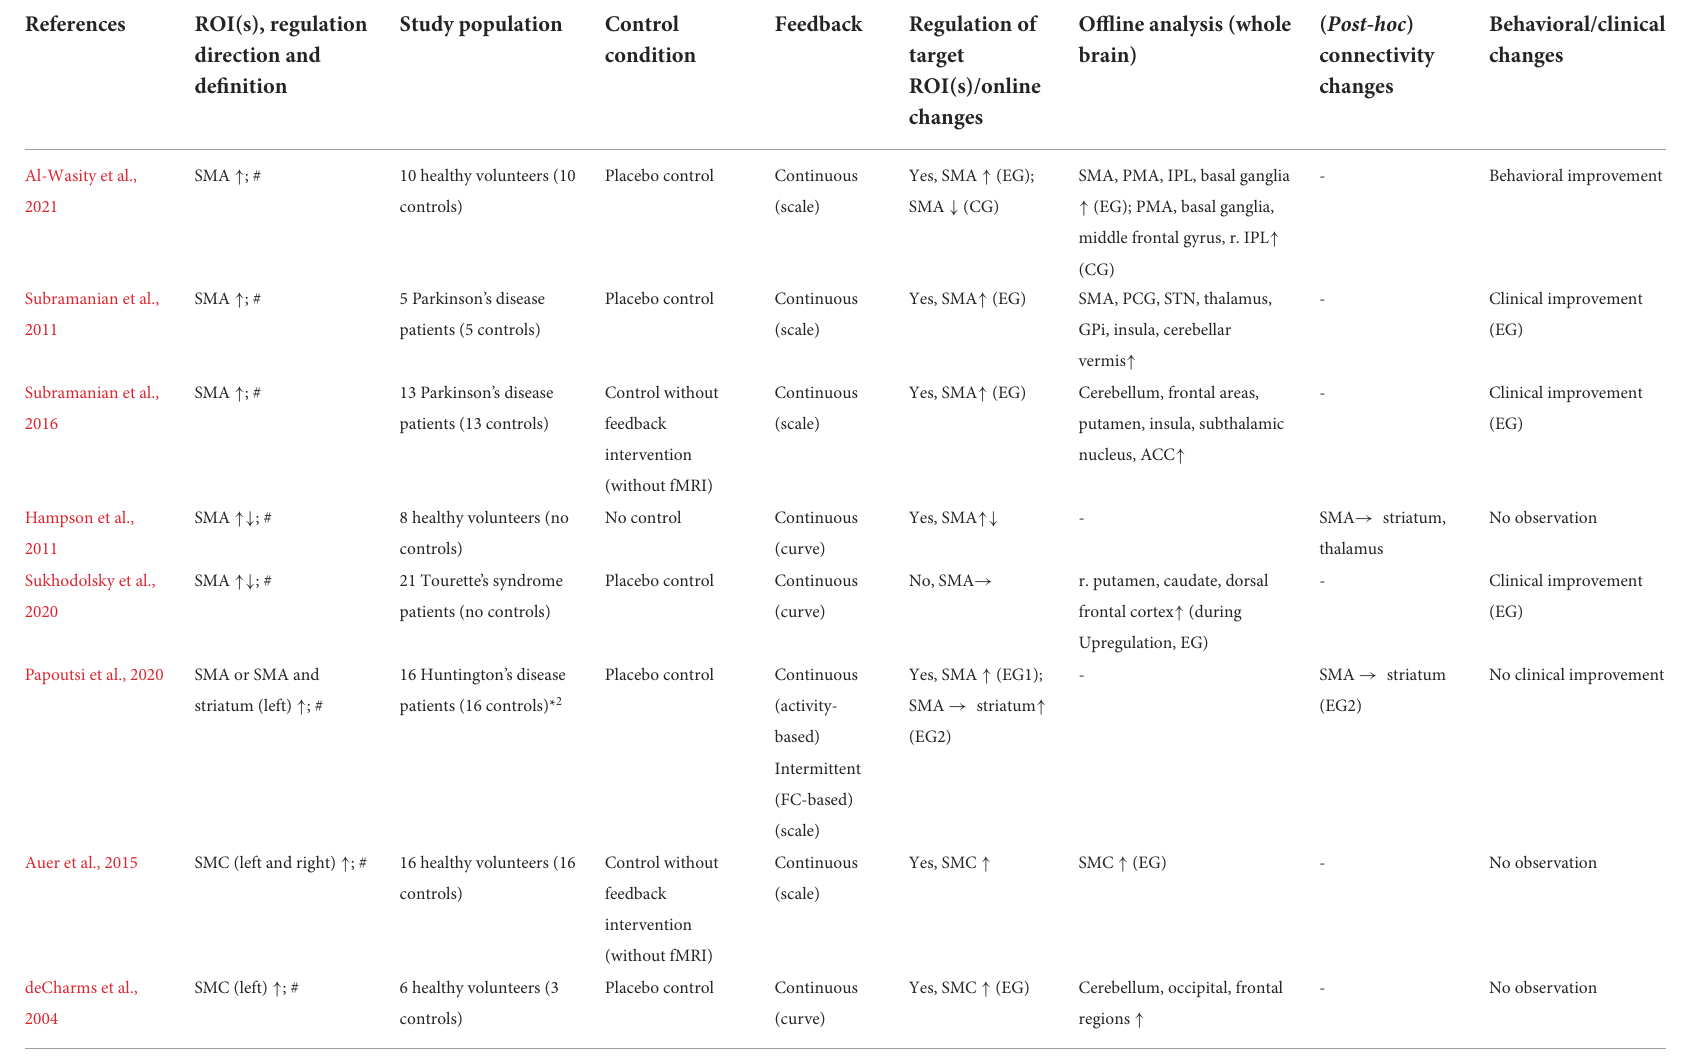
Thepublicationsaresortedbasedontheregion(s)ofinterest. CG, control group; EG, experimental group; fMRI, functional magnetic resonance imaging; HV, healthy volunteers; MCA, middle cerebral artery; NF, neurofeedback; ROI, region of interest; ACC, anterior cingulate cortex; AI, anterior insula; DMN,